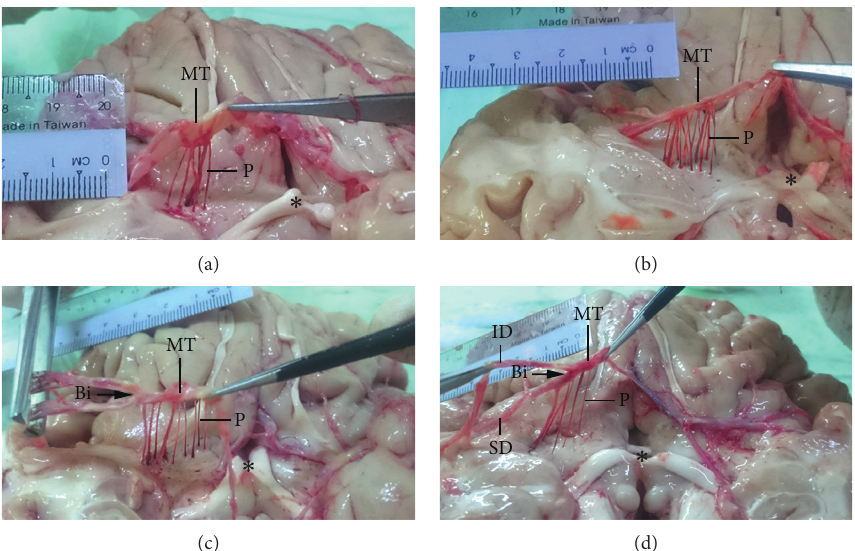
Figure 3: Perforators of the MCA. Six (a) and 15 (b) perforators (P) arising from the MTof the MCA as single branches. (c) Nine perforators arising from both the MT and bifurcation (Bi) point. (d) Lifting the inferior division (ID) by the forceps revealed the emergence of 5 perforators not only from the MT but also from the bifurcation and postbifurcation divisions comprising superior and inferior divisions (SD and ID, respectively). ∗ Optic chiasma. Table 2: Length of the main trunk of the MCA and number of perforators and cortical branches. Length of main trunk of the MCA (mm)